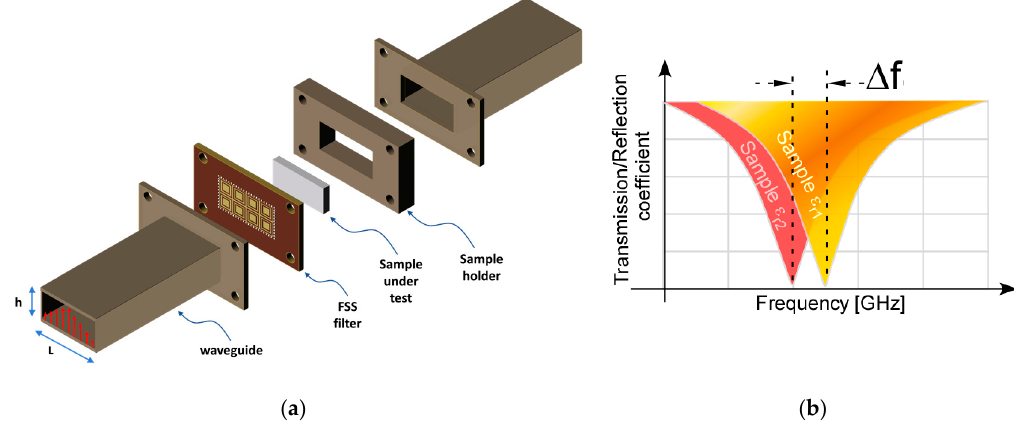
Figure 13 . ( a ) Resonant measurement setup in a waveguide based on FSS filters; ( b ) estimation principle.